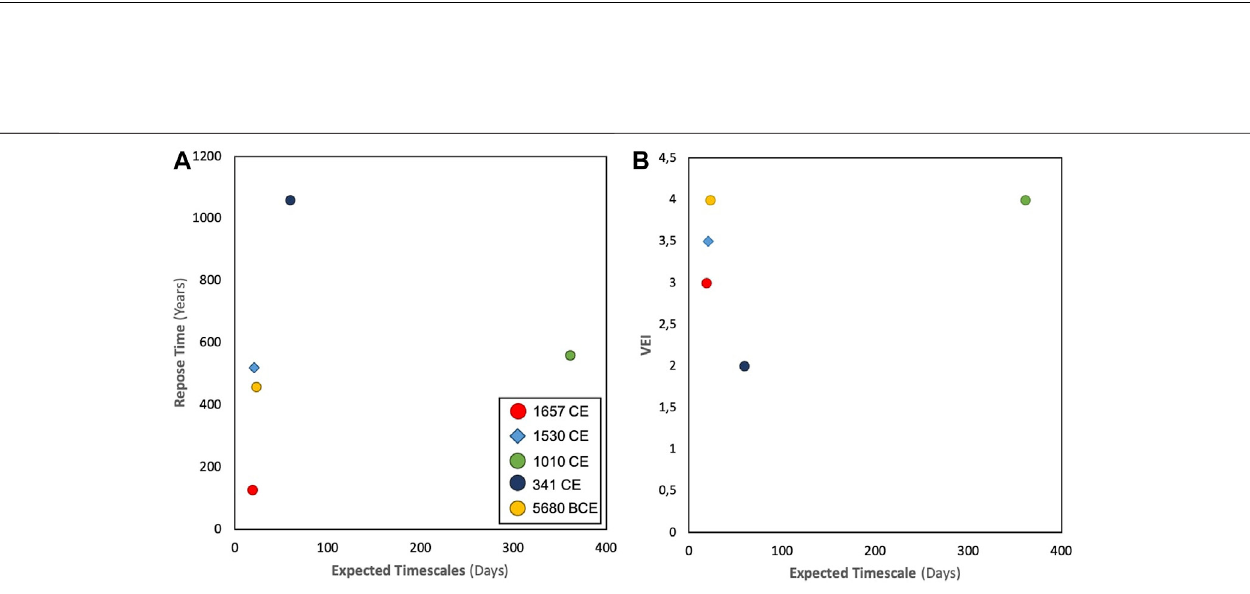
Frontiers in Earth Science |